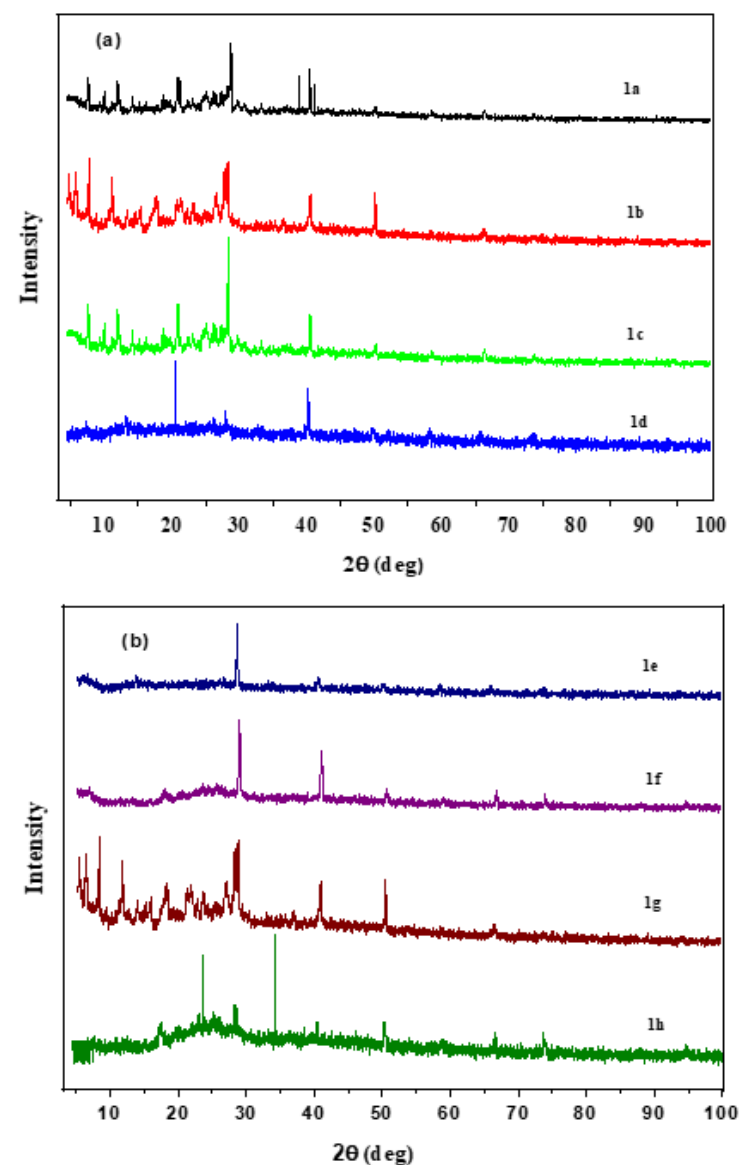
Figure 4. Powdered X-ray patterns of ( a ) complexes 1a – 1d and ( b ) complexes 1e – 1h .